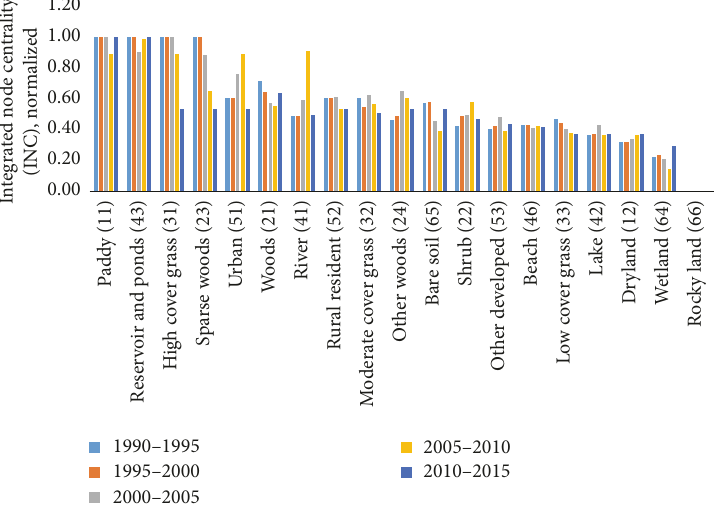
Figure 4: The identification of key land use types based on INC (ranked by average INC